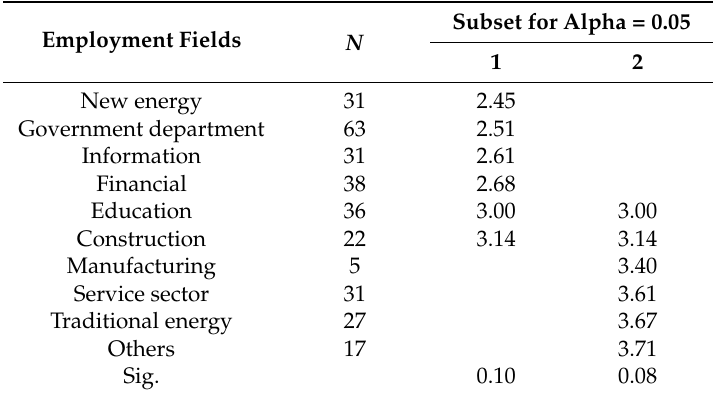
Table 10. Public’s subsidies expectations of different employment